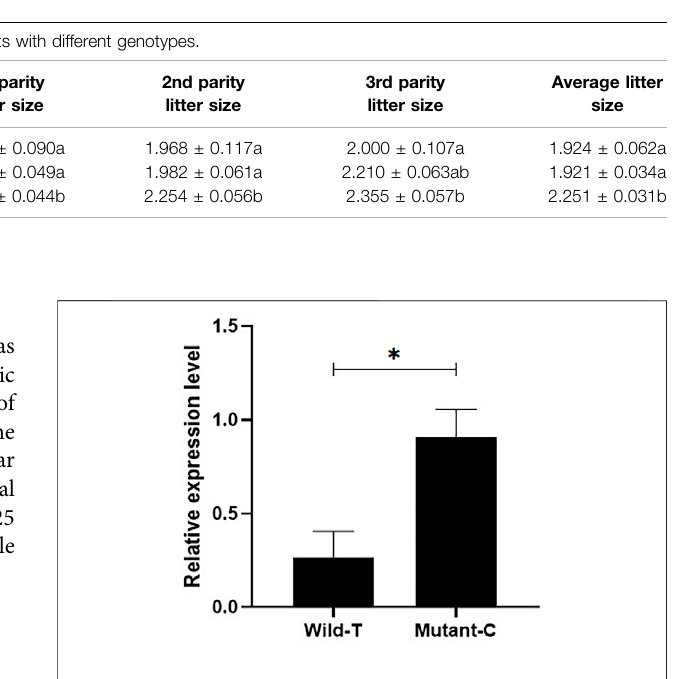
FIGURE1| Detection ofthe expression ofdifferent genotypes of IGF1 in goat ovaries. Bars represent the mean ± SEM of at least three repeats. * p < 0.05; ** p <